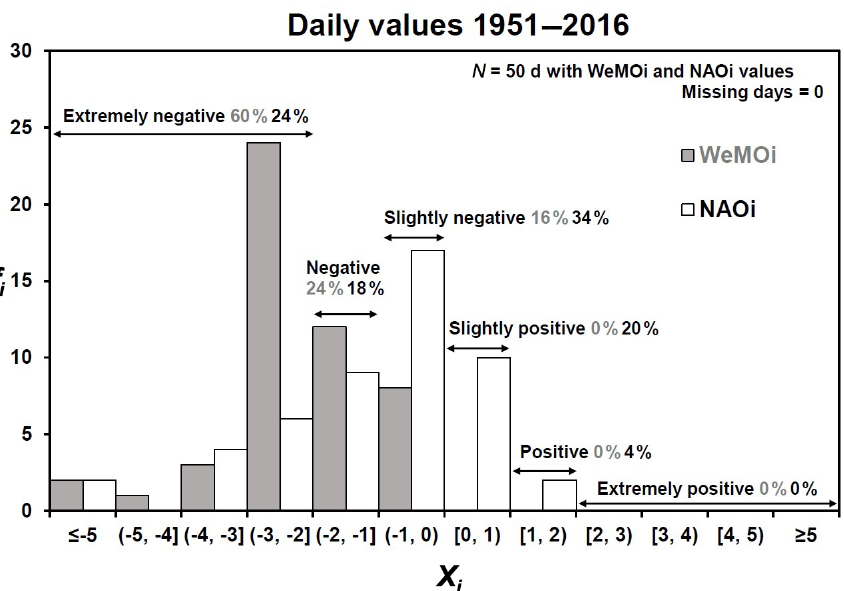
Figure 5. Frequency histogram of the daily WeMOi and NAOi values of the 50 extreme torrential events recorded in Catalonia during the 1951–2016 study period.